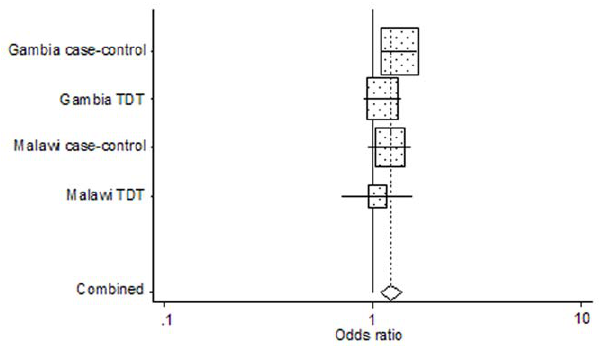
Figure 2. Forest plot of the odds ratios of severe malaria allelic associations at the rs5751876 locus. Odds ratios of severe malaria associations with the rs5751876 C allele are represented for each study as a grey box with a horizontal line. The mid-point of the line represents the odds ratio and the extreme points of the line represent the 95% CI. The contribution of each study to the meta-analysis is represented by the area of the grey box. The solid vertical line presents an odds-ratio of 1 (no association). The diamond at the bottom presents the overall odds ratio and CI: OR=1.12 (95% CI: 1.02–1.23), P=0.024. Cochran’s Q- test for heterogeneity on 4 degrees of freedom: